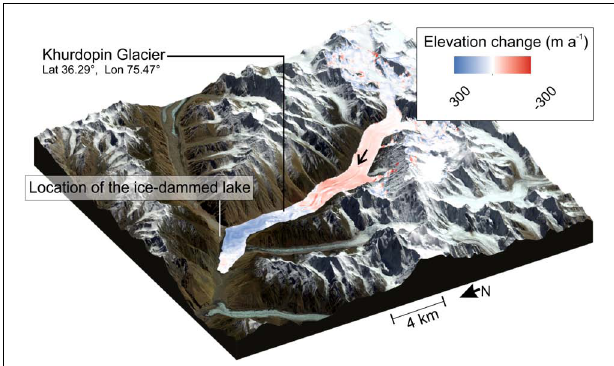
FIGURE 5 | Elevation change on the Khurdopin Glacier during the build-up (2015–2016) and surge phase (2017) from Steiner et al. (2018). Background is a Sentinel-2 composite of bands NIR, red, blue (20 September